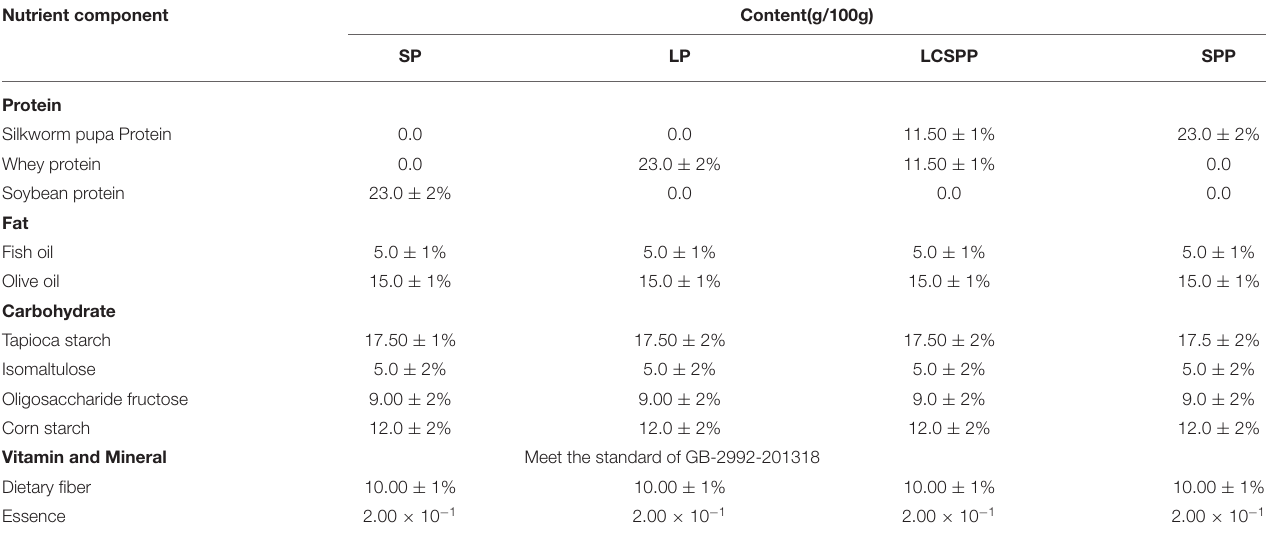
TABLE 1 | The enteral formula design of four special